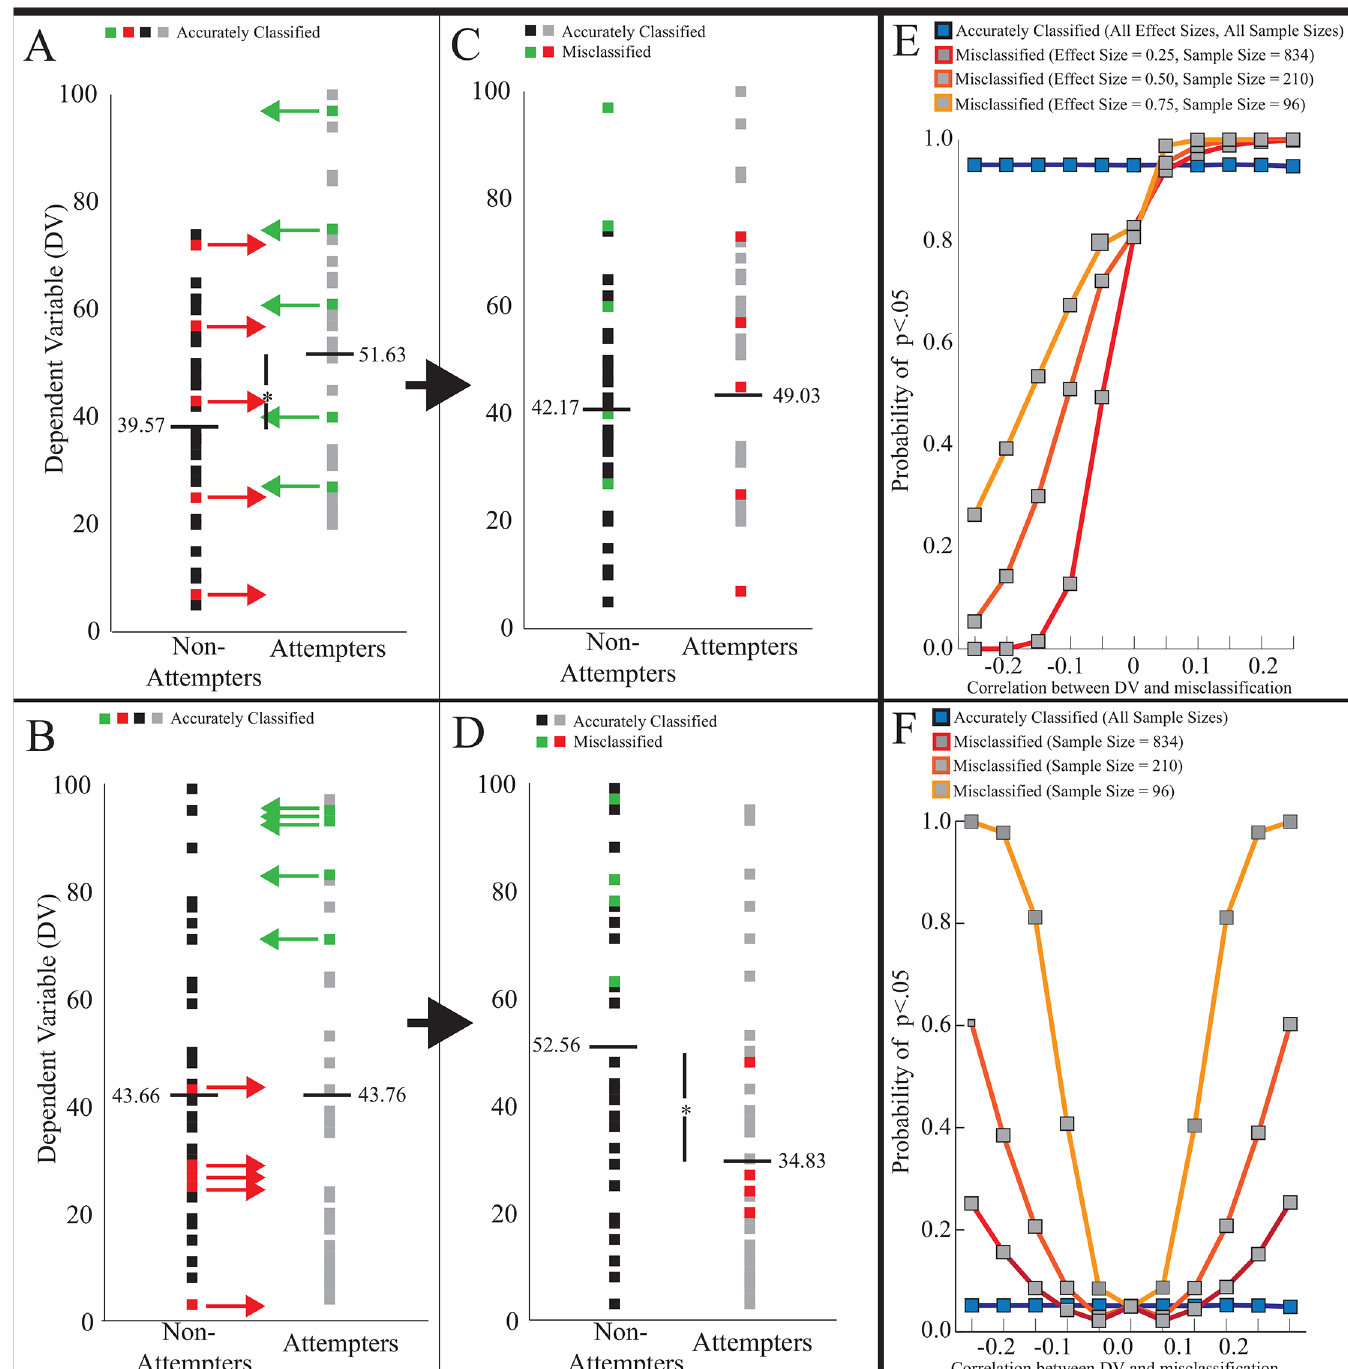
Fig 2. A visual example of DV-misclassification relationships and the results of the statistical simulations. (A) Model data of a “ true effect" (B) Model data of a “ true null effect. ” The red and green arrows in (A) and (B) represent data points that will be misclassified due to participants inaccurately categorizing their suicidal behavior. (A) and (C) show an example of when the misclassification is random (i.e., dependent variable (DV)-misclassification correlation is zero). Because true attempters tend to be higher on the DV, true attempters randomly misclassified into the non-attempters group will tend to increase the group mean of non-attempters (e.g., from 39.57 in (A) to 42.17 in (C)). Likewise, in the example, true non-attempters tend to be lower on the DV and therefore, true non-attempters randomly misclassified into the attempters group will reduce the group mean of attempters (e.g., from 51.63 (A) to 44.03 in (C)). Thus, when there is a true difference between the groups at the population level, random misclassification will cause the two group means to move closer together reducing the power to detect the true effect. (B) and (D) shows an example of when there is a pattern to the misclassification (the DV-